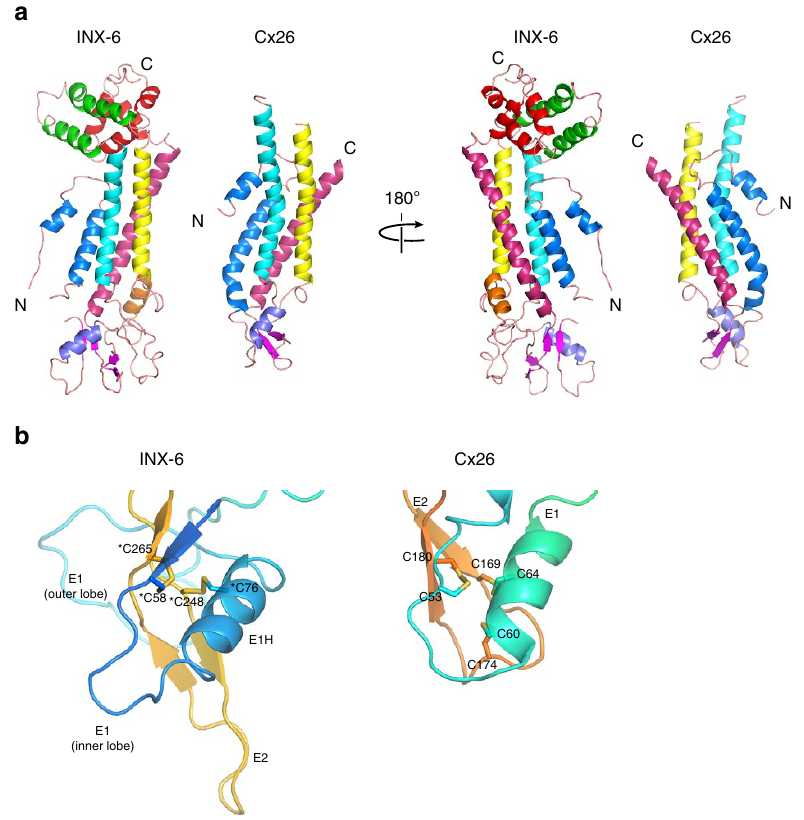
Figure 3 | Similarity between the INX-6 and Cx26 monomers. ( a ) The monomeric structures of INX-6 and Cx26 (pdb code: 2zw3) 9 are presented side by side. Each transmembrane helix is coloured as follows: TM1 in blue, TM2 in cyan, TM3 in yellow and TM4 in pink. b -sheets are coloured magenta. The N- and C- termini are indicated by ‘N’ and ‘C’, respectively. The two structures were compared using a Dali server 48 , and the Z score was 7.9, suggesting that the protein-folding of the two structures is highly correlated. ( b ) Distributions of disulfide bonds in the extracellular loops of INX-6 and Cx26 when their transmembrane helices are aligned. (left) E1 and E2 of INX-6 are linked by two disulfide bonds of C58-C265 and C76-C248 (asterisks). (right) Three disulfide bonds between E1 and E2 of Cx26 (ref.